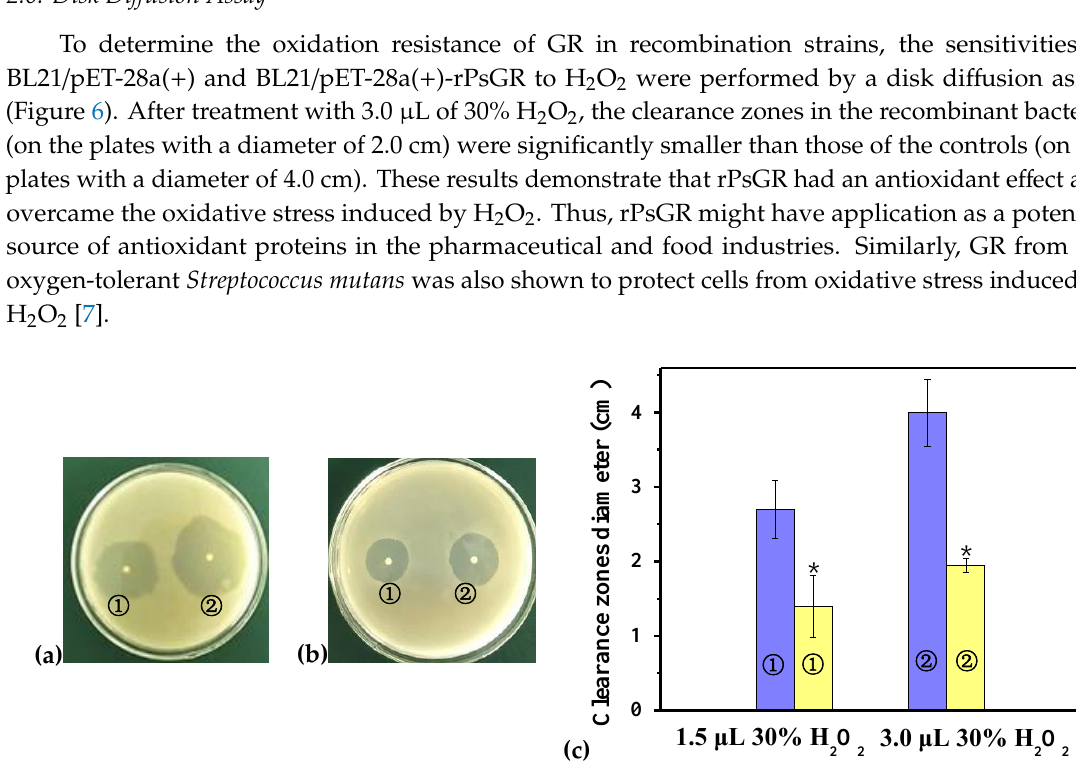
Figure 6. Sensitivity of BL21/pET-28a(+) and BL21/pET-28a(+)-rPsGR to killing by H 2 O 2 . ( a ) The clearance zone diameters (cm) were measured in the plates with BL21/pET-28a(+) after oxidative stress with 1.5 ( ① ) and 3.0 μL 30% H 2 O 2 ( ② ). ( b ) The clearance zone diameters (cm) were measured in the plates with BL21/pET-28a(+)-rPsGR after oxidative stress with 1.5 ( ① ) and 3.0 μL 30% H 2 O 2 ( ② ). ( c ) The clearance zone diameters of BL21/pET-28a(+) (blue) and BL21/pET-28a(+)-rPsGR (yellow) after oxidative stress with 1.5 ( ① ) and 3.0 μL 30% H 2 O 2 ( ② ) were shown in a bar graph form. Data are presented as mean ( n = 3) ± SD. *, p < 0.05, representing a significant difference from the control.